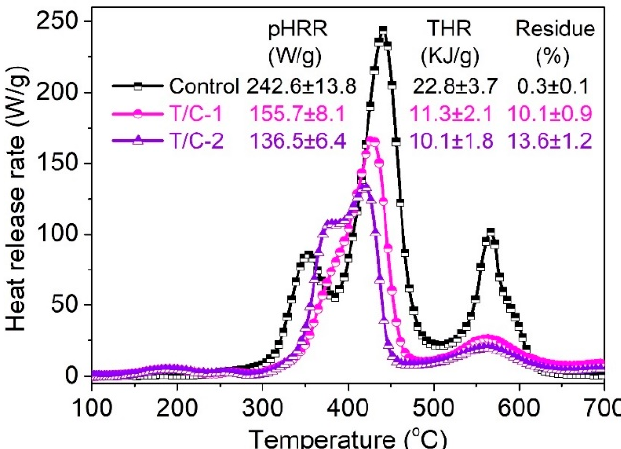
Figure 5. HRR curves of coated T/C blend